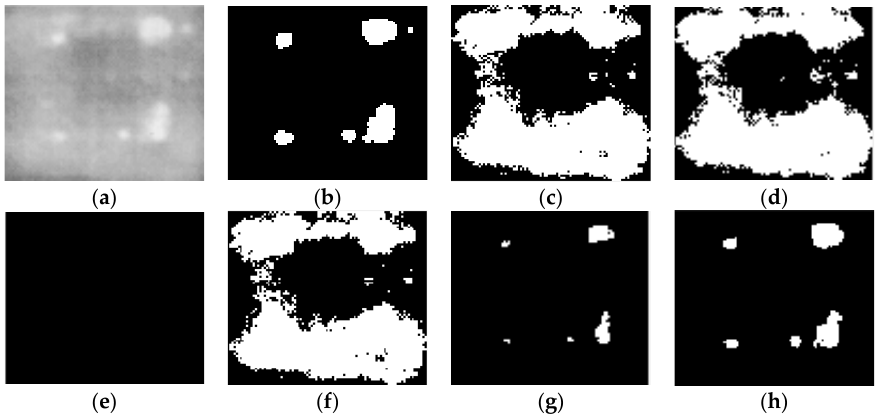
Figure 7. Image3 and its segmentation results: ( a ) #image3, ( b ) ground-truth, ( c ) Otus, ( d ) MRCUT,